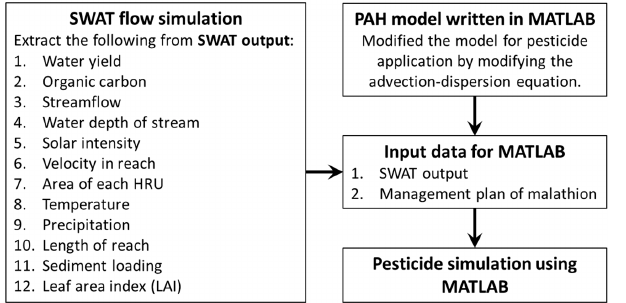
Figure 4. Flow diagram of the modified pesticide model. SWAT output and management plan of malathion were used as input in MATLAB for the pesticide simulations.